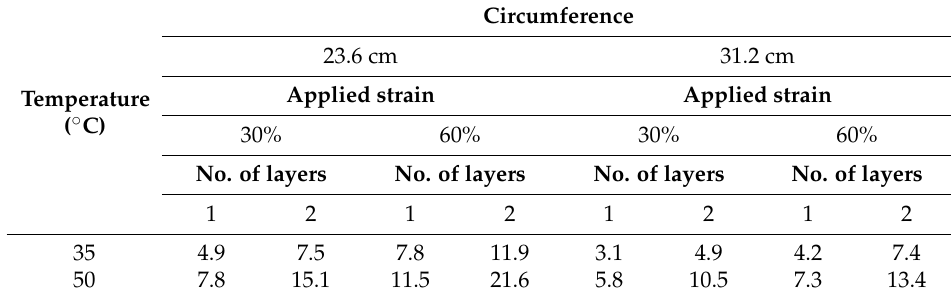
Figure 6. Cyclic pressure variation by the bandage upon continuous heating and cooling cycles. Each cycle (C 1 to C 10 ) includes heating of the bandage for 10 min in heated chamber ( T = 50 °C), and then cooling down for another 10 min at room temperature ( T = 23 ° C).